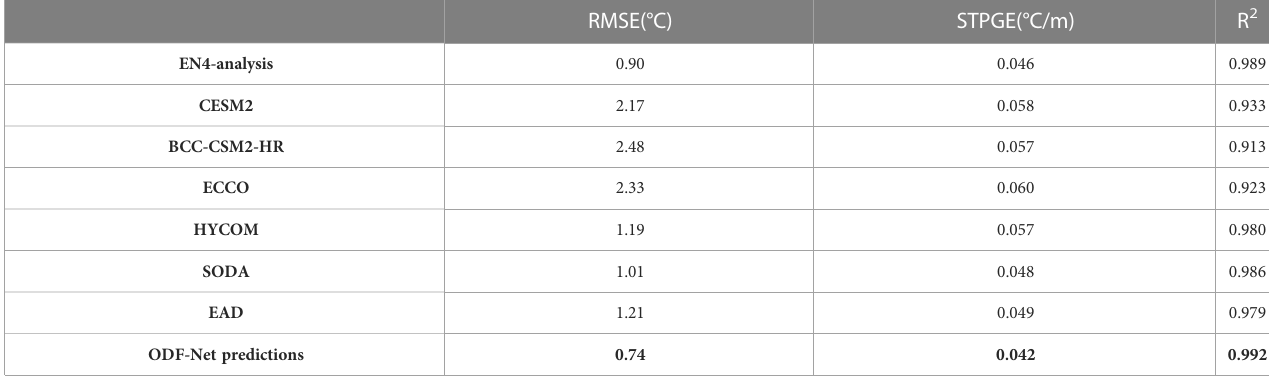
TABLE 3 Comparison of metrics on test set of different data sources.